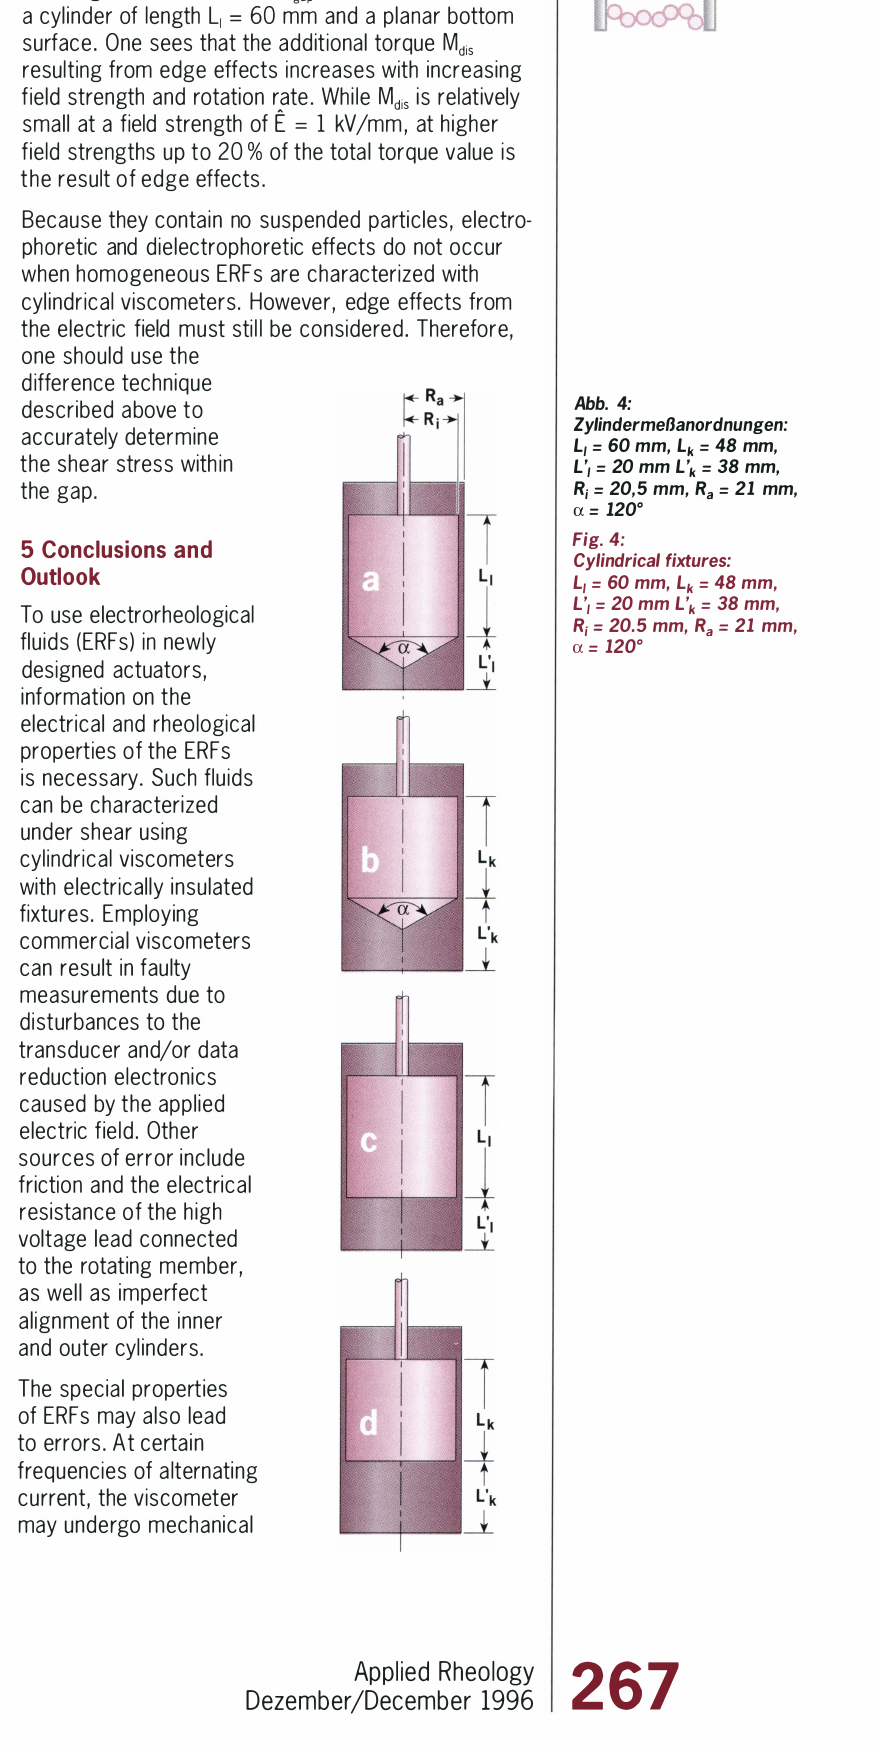
Fig. 4: Cylindrical